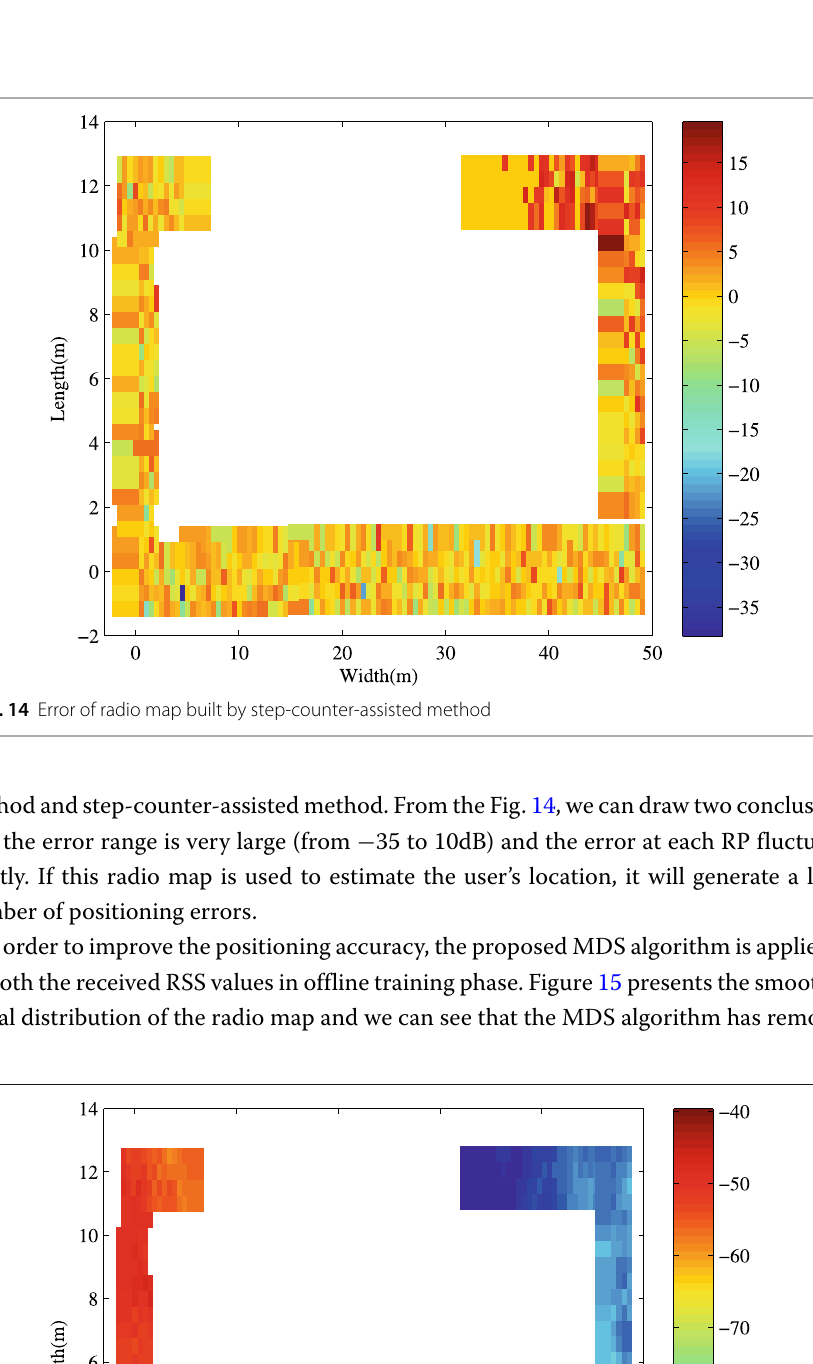
Fig. 15 Signal distribution of smoothed radio